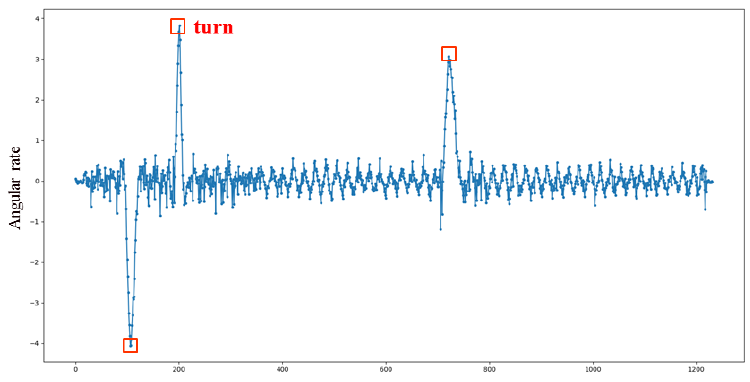
Figure 5. Heading orientation deviation after a turn.